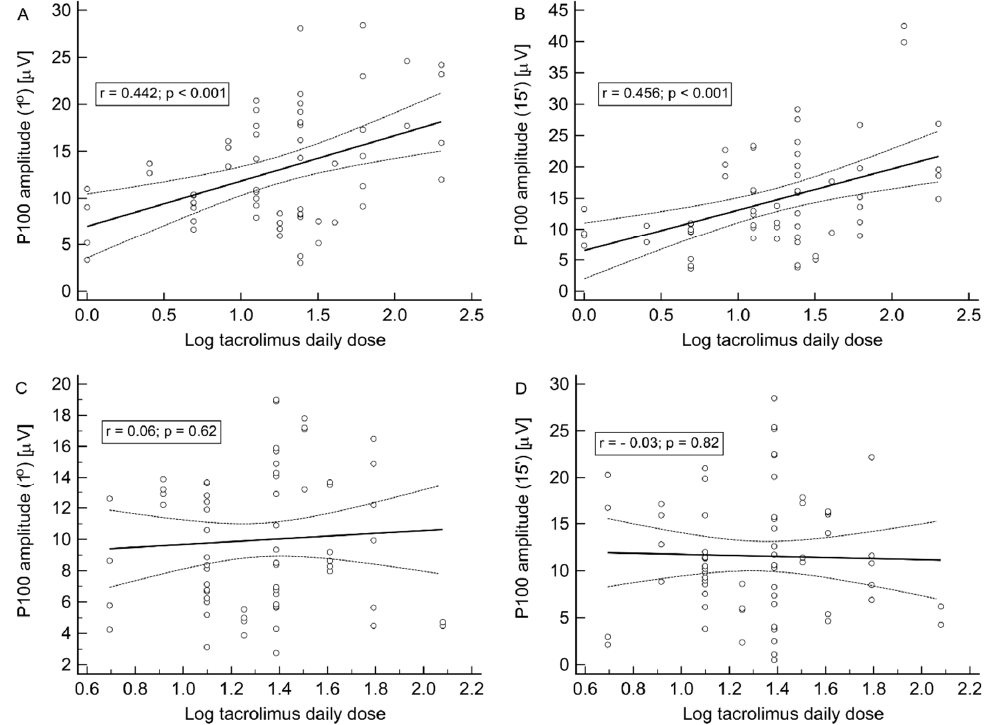
Figure 4. The pattern VEP examination. The associations of both P100 wave (1°) and (15 ′ ) amplitudes with log tacrolimus daily dose in the Prograf ( A ) and ( B ) and the Advagraf ( C ) and ( D ) subgroups.